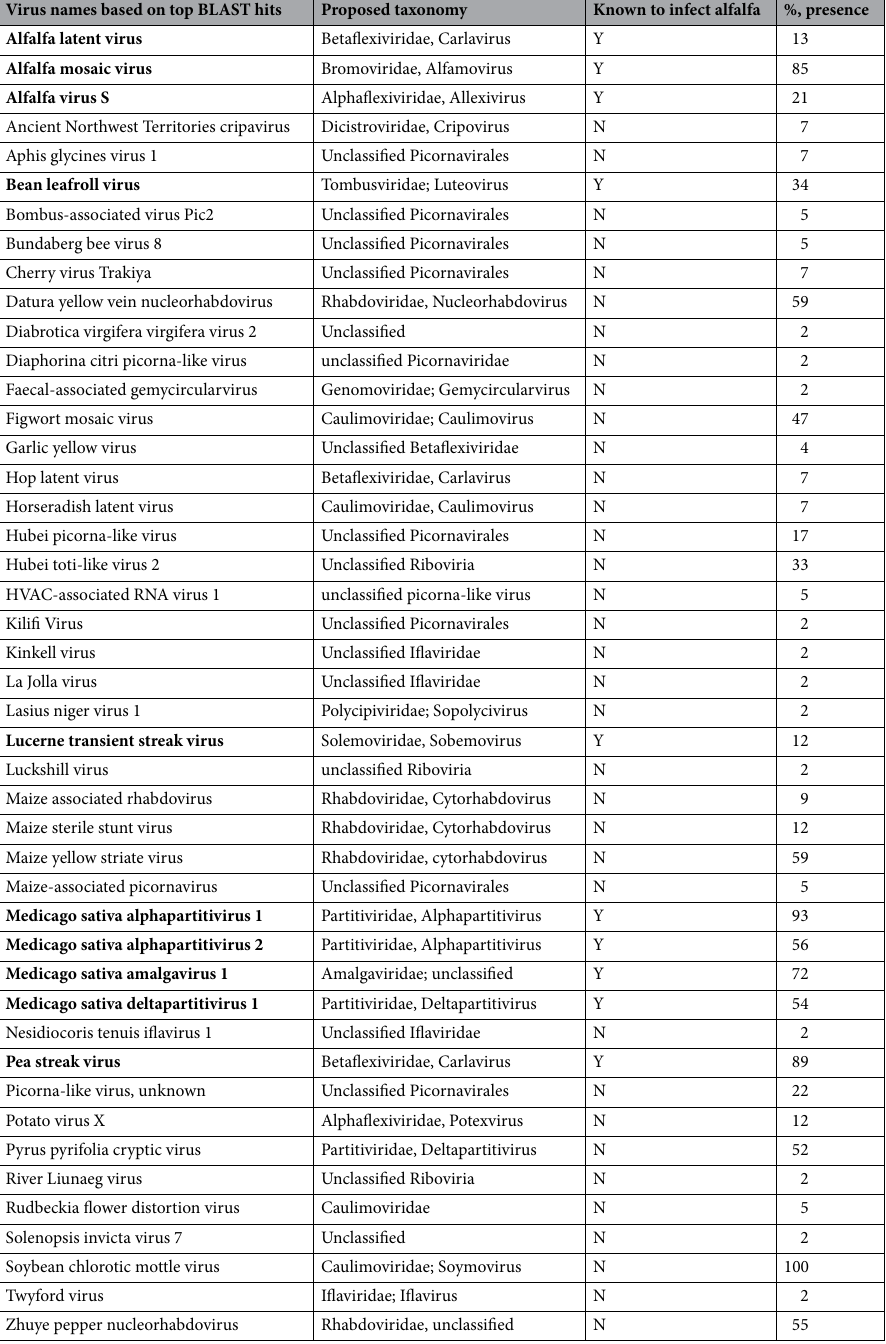
Table 1. A list of viruses identified based on RNA sequencing data in alfalfa samples collected from production fields in the U.S. Pacific Northwest in 2019/2020. Bold font: viruses known to infect